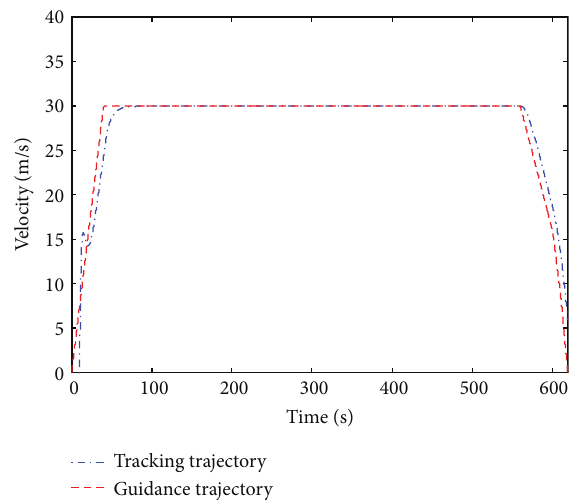
Figure 3: Train velocity tracking curve (single model